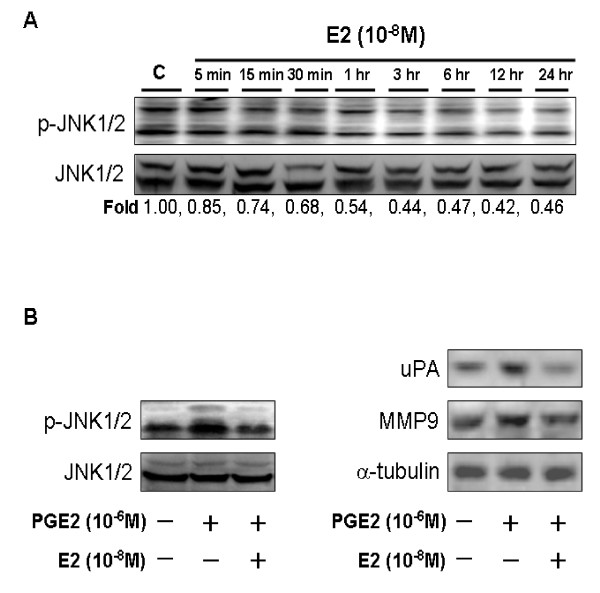
17β-Estradiol down-regulates PGE2-induced uPA and MMP-9 expression by suppressing activation of JNK1/2 in human LoVo cells. (A) LoVo cells cultured in DMEM were treated with 17β-estradiol (10-8M) for various periods (5 min, 15 min, 30 min, 1 h, 3 h, 6 h, 12 h and 24 h), and subsequently measured the phosphorylation/activation of proteins by immunoblotting assay. The fold ratio of p-JNK1/2 and JNK1/2 was measured. (B) LoVo cells were pretreated with 17β-estradiol (10-8M) for 30 min, followed by PGE2 (10-6M) treatment for 30 min or 24 h, and then were subjected to immunoblotting assay for protein detection of phospho-JNK1/2 (PGE2 stimulation within 30 min); uPA and MMP-9 (PGE2 stimulation within 24 h).